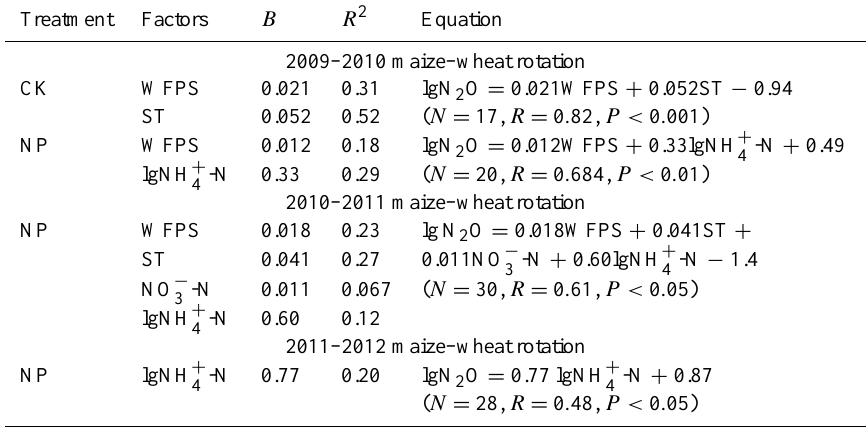
Table 2. Regression analysis between N 2 O flux (ngNm − 2 s − 1 ) and its regulating factors in the maize–wheat